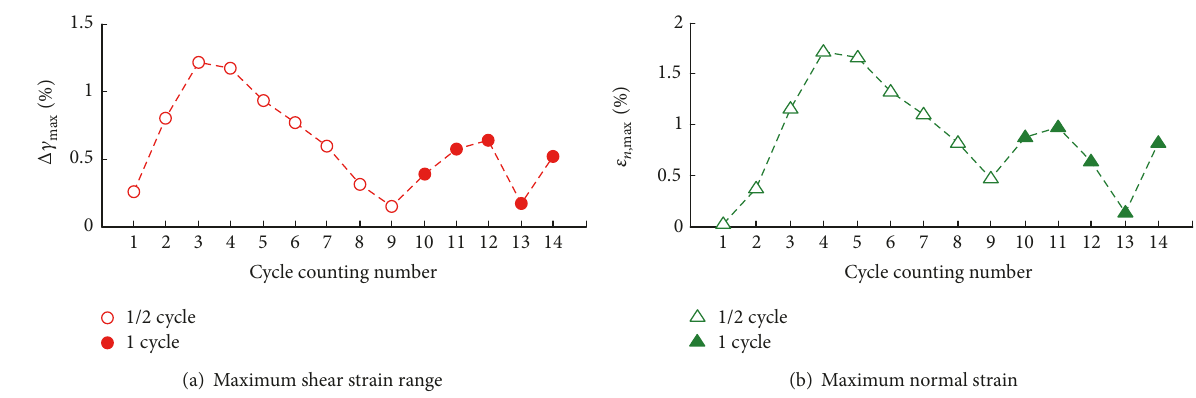
Figure 21: Cyclic rainflow counting results of shear strain range and normal strain of critical